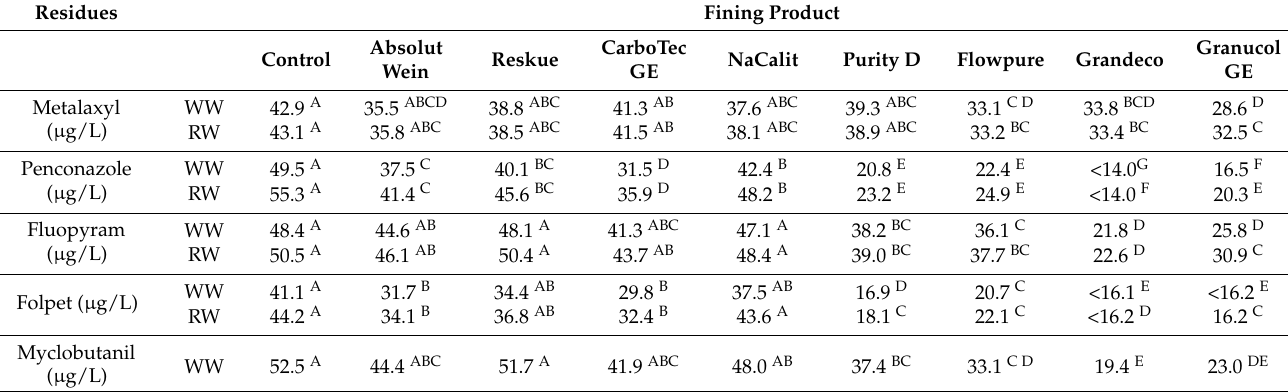
Table 6. Concentration of Fungicides (without botryticides) before and after treatment with different fining agents.